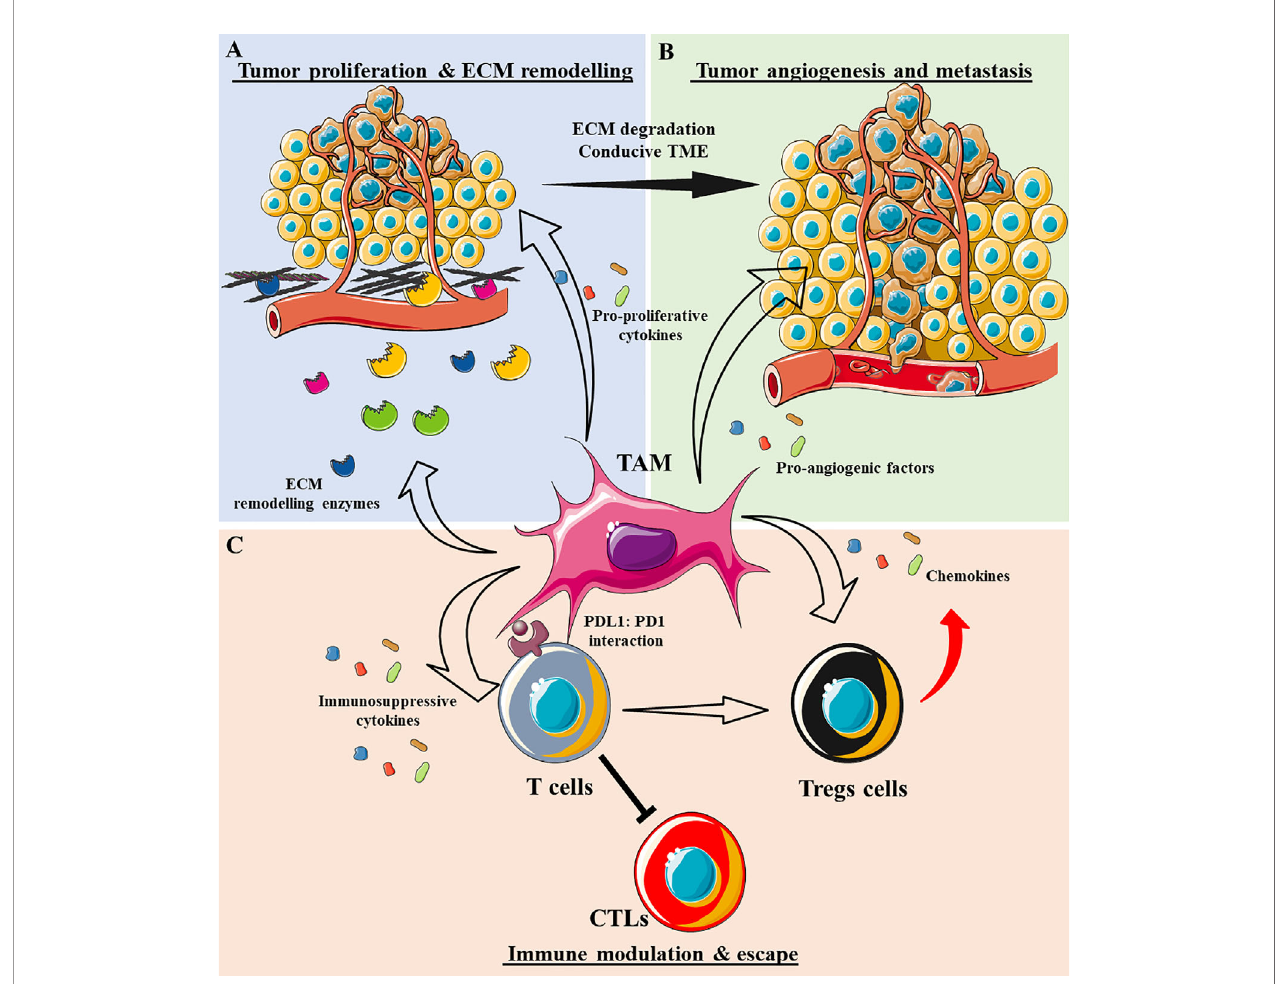
FIGURE 3 | The role of tumor-associated macrophages (TAMs) in shaping the tumor microenvironment (TME). (A) TAMs secrete a plethora of enzymes that degrade ECM components, such as metalloproteinases (MMPs), cathepsins, disintegrin and metalloproteinase (ADAM)-family proteases, and tissue inhibitors of metalloproteinases (TIMPs). As a result, the ECM becomes destructured and conducive to tumor cell invasion. TAMs also secrete cytokines that support tumor cell proliferation, e.g., TGF- b 1, IL-10, IL-6, IL-1 b , and EGF. (B) TAMs secrete various pro-angiogenic factors that induce vessel formation, e.g. , VEGF-A, bFGF, IL-6, and TNF a . Together with ECM degradation, tumor angiogenesis permits the systemic dissemination of tumor cells. (C) TAMs adopt an immunosuppressive phenotype by secreting many anti-in fl ammatory cytokines/chemokines, e.g. , IL-10, TGF- b 1, CCL17, CCL18, and CCL22, inhibiting cytotoxic T cells (CTLs) and attracting or differentiating T cells into regulatory T cells. TAMs can also exhaust CTLs by direct engagement of anti-in fl ammatory cognates receptors like PD1-PD-L1.